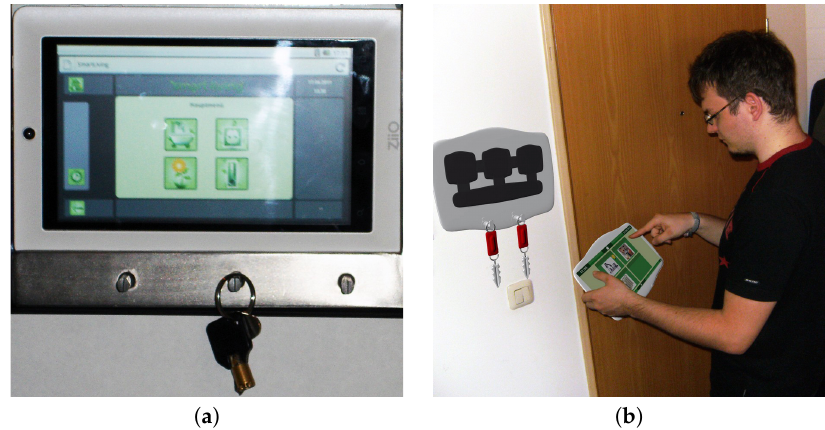
Figure 17. A key-holder interactive tool ( a ) used as part of the Smart Living project, to inform people about their energy-consuming devices as they are about to live their home and enabling them to act ( b ). Images from Reference [66].